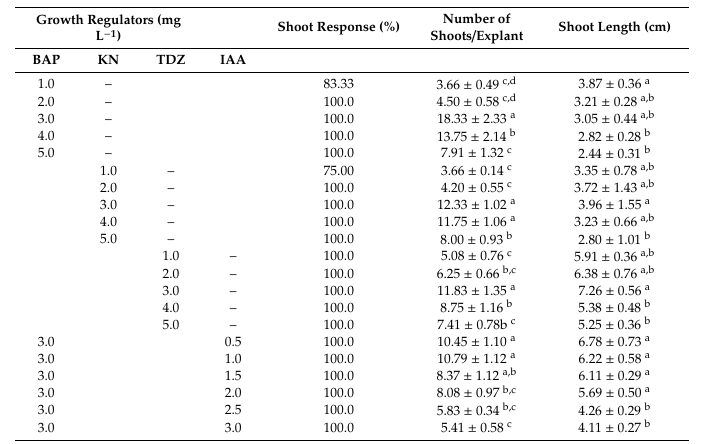
Table 3. Influence of cytokinins on multiple shoot bud induction of A. longiloba using an individual